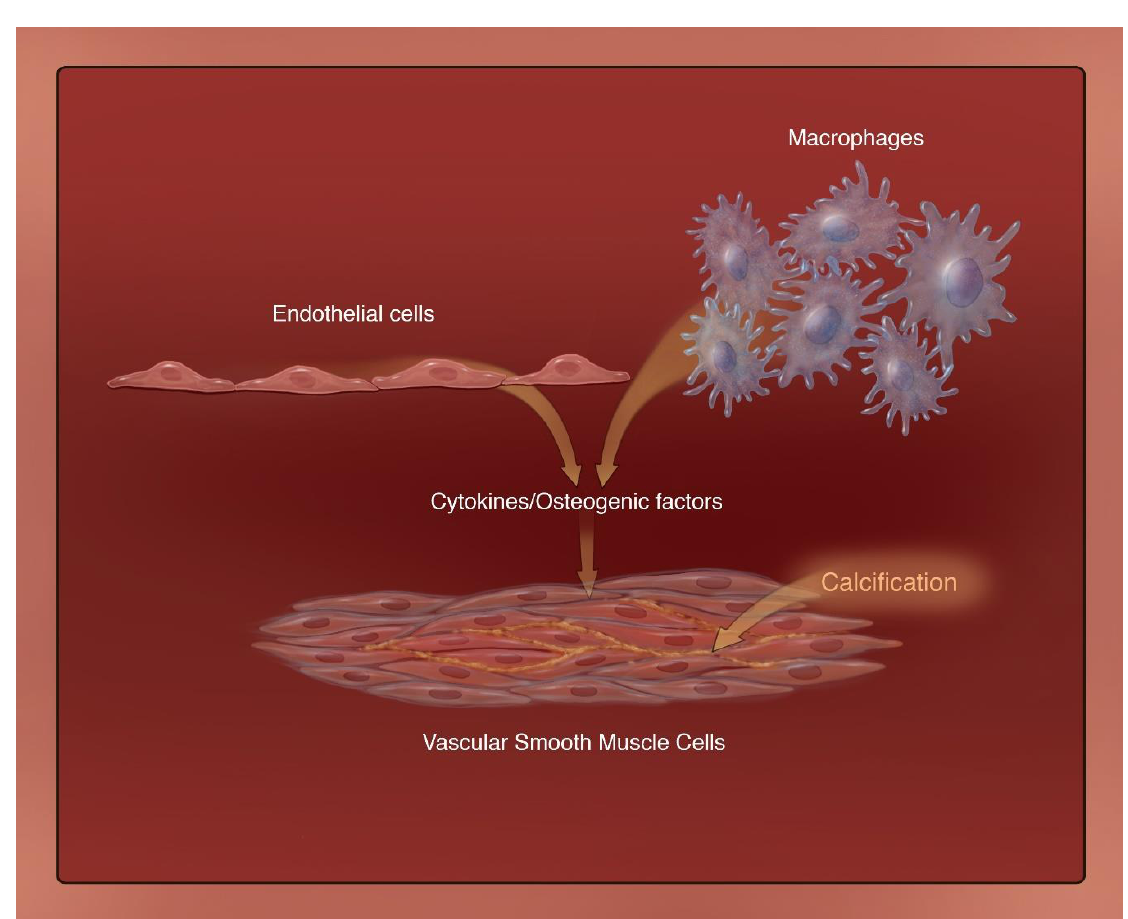
Figure 4. The cellular trifecta of vascular calcification: Endothelial cells and macrophages can secrete various cytokines and osteogenic factors that lead to the activation and progression of calcification in vascular smooth muscle cells.